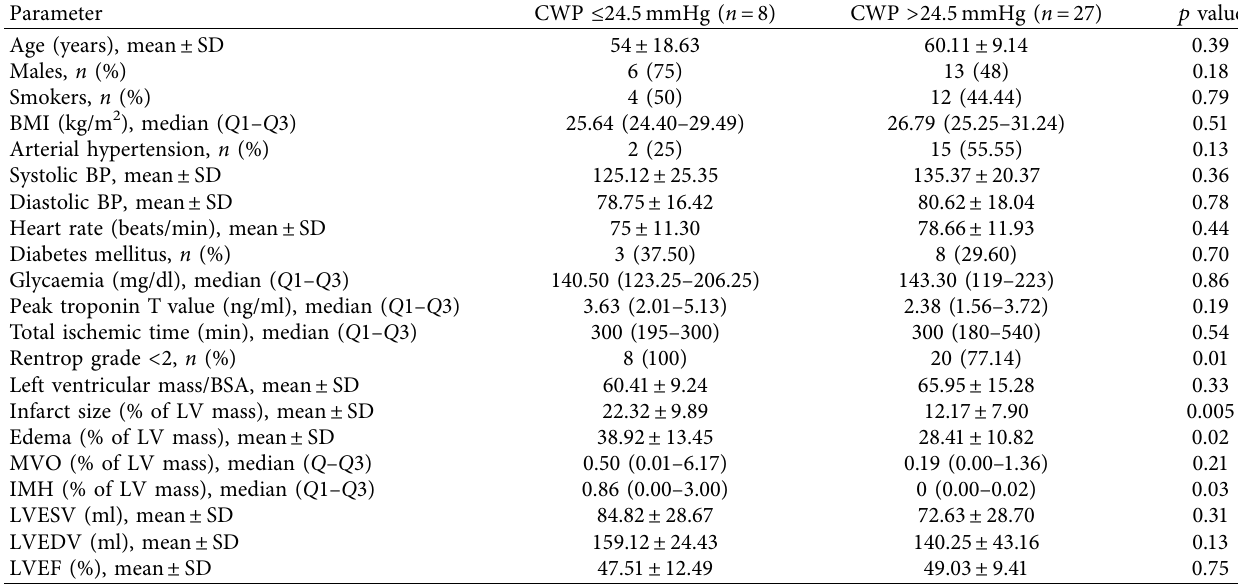
Table 3: Patients’ characteristics according to the mean CWP 24.5mmHg cutoff for infarct size.